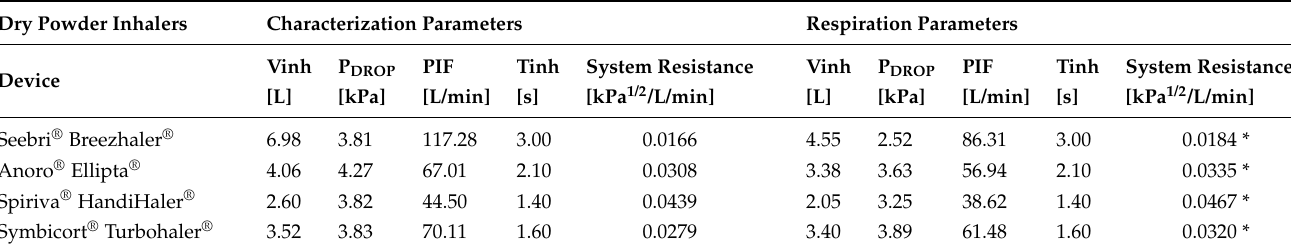
Table 3. Summary of the relevant parameter values for the used DPIs during characterization and respiration measurements. V INH —inhaled volume, P DROP —pressured drop across the inhaler during inhalation, PIF—peak inspiratory flow, and t INH —inhalation